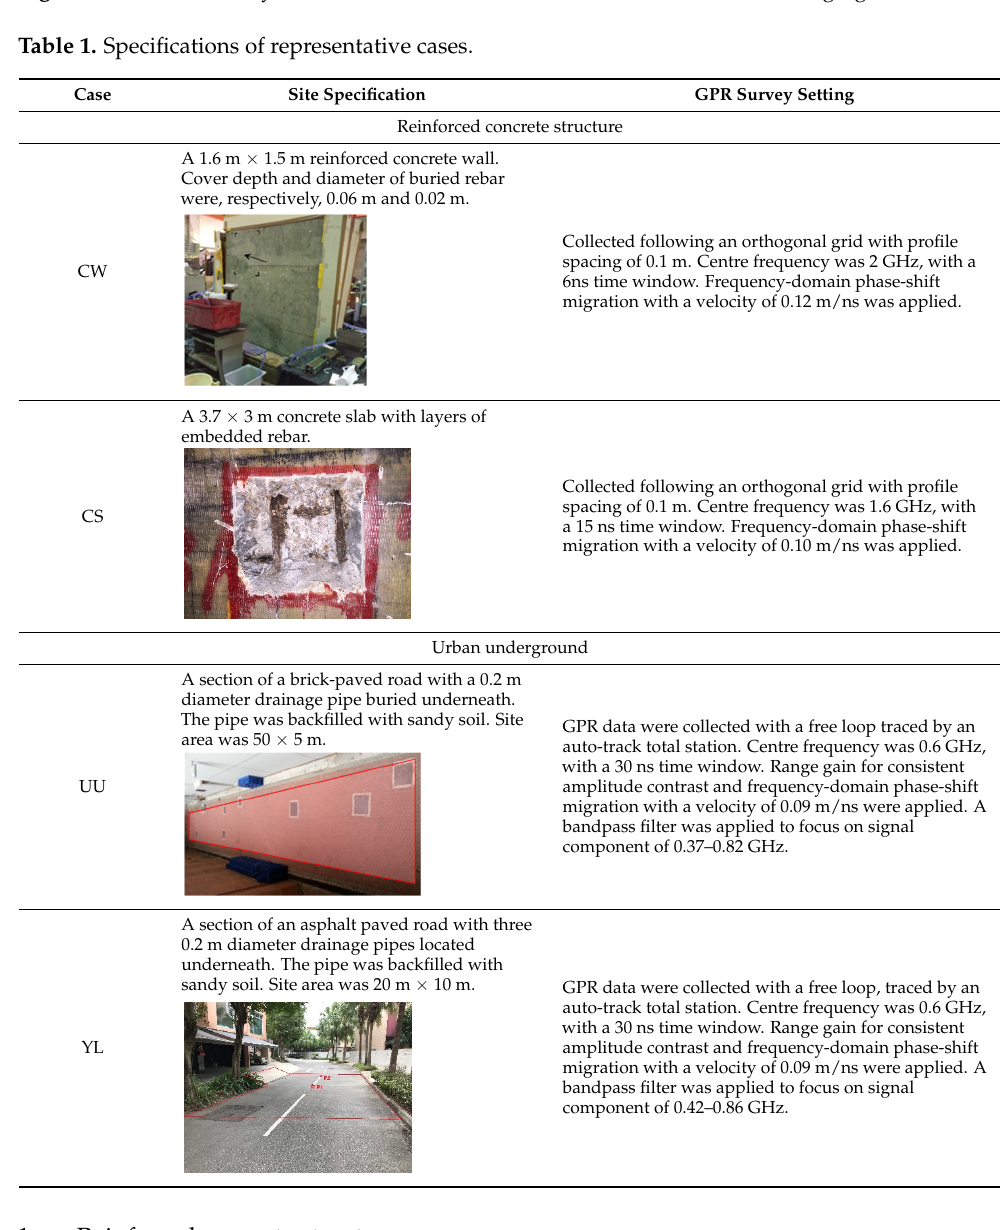
Figure 1. C-scan intensity normalisation scheme that continuous the 3D GPR imaging workflow. Table 1. Specifications of representative cases.